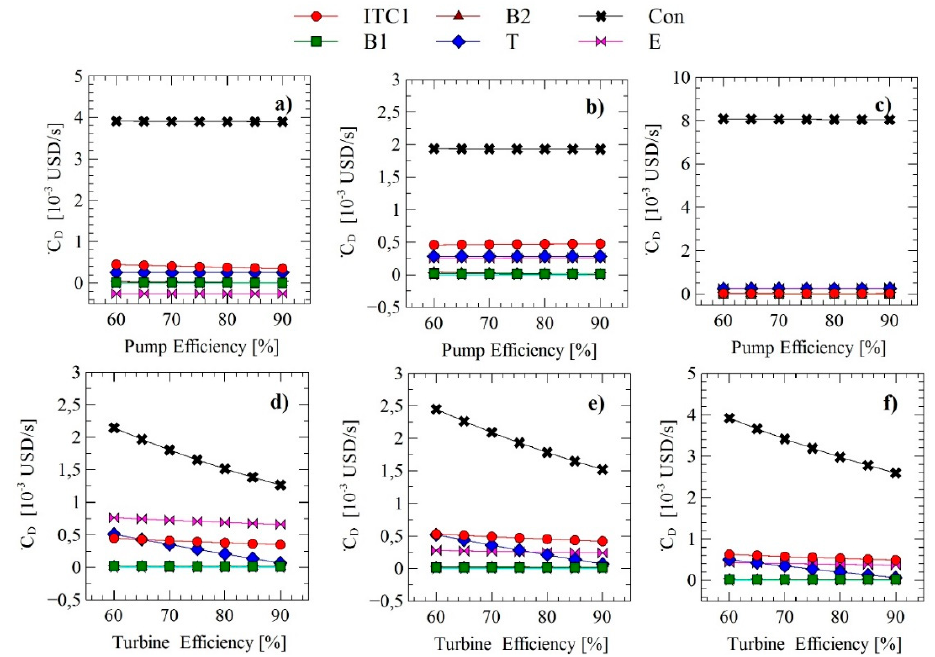
Figure 5. Effect of turbine and pump efficiency on the cost of exergy destroyed by component using Figure 5. E ff ect of turbine and pump e ffi ciency on the cost of exergy destroyed by component using as as organic working fluids ( a , d ) toluene, ( b , e ) acetone, ( c , f ) cyclohexane. organic working fluids ( a , d ) toluene, ( b , e ) acetone, ( c , f )